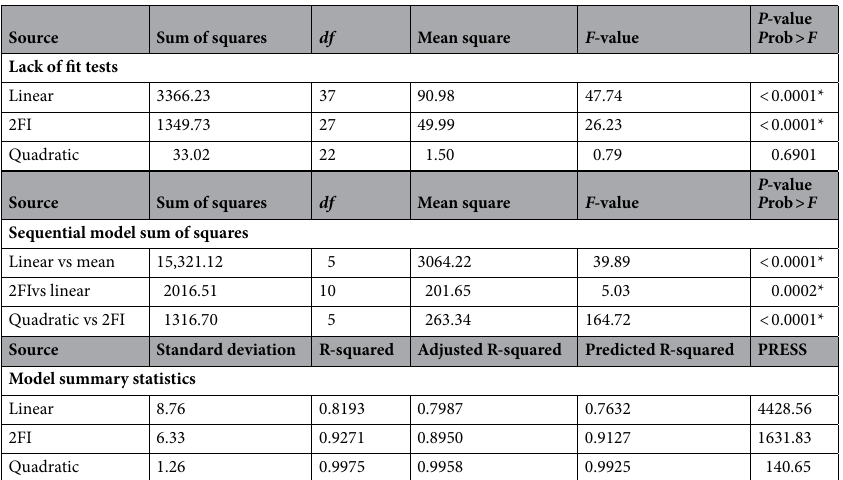
Table 5. Fit summary for simultaneous biosorption of Cobalt by E. intestinalis achieved by the FCCCD. *Significant values, df , degree of freedom; PRESS, sum of squares of prediction error; two factors interaction,